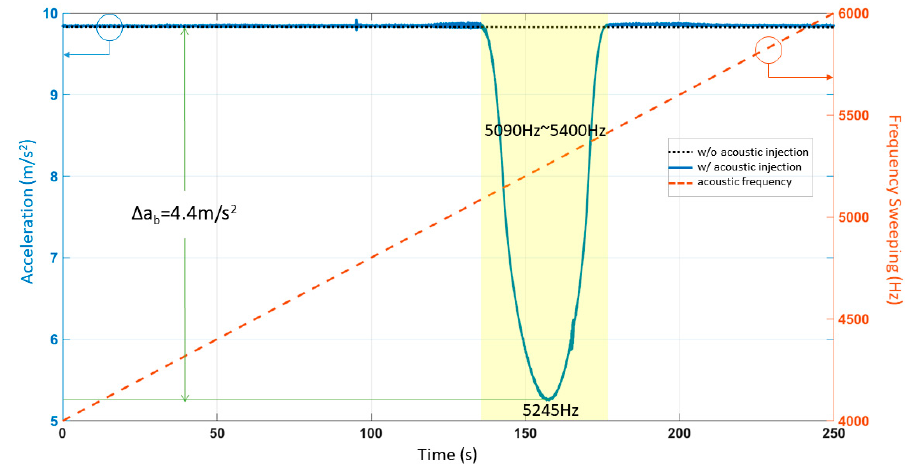
Figure 2. The output acceleration of ADXL103 under the acoustic injection attack of frequency sweeping.